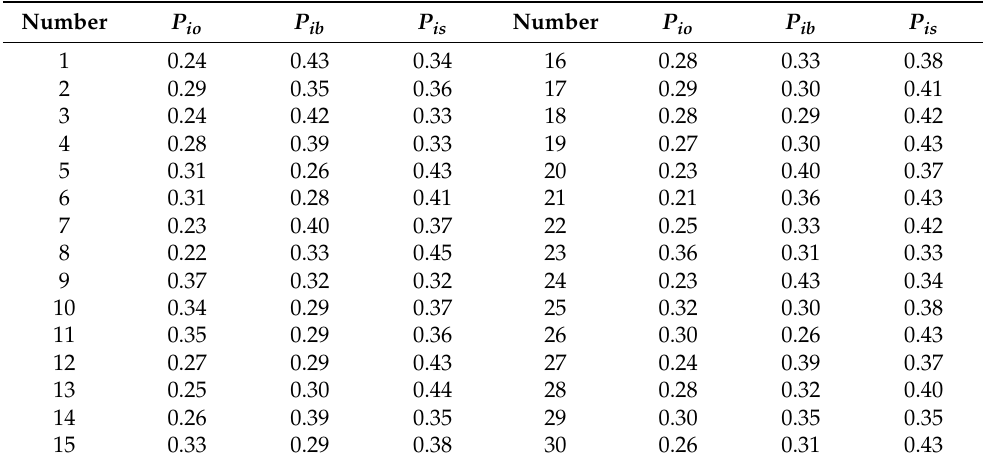
Table 8. Selection probability of each demand point for three purchase